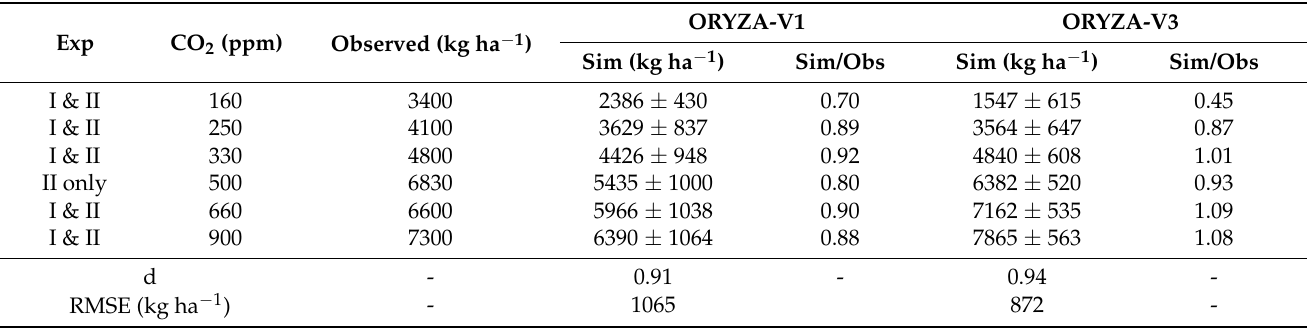
Table 3. Comparison of observed (Obs) and simulated (Sim) rice grain yield for ORYZA-V1 and ORYZA-V3 model versions in response to varying CO 2 concentrations. Data were averaged from two different experiments, Exp I and II, that varied in planting date (22 January or 23 June) from [52]. The ratio of simulated to observed yield (Sim/Obs) was indicated along with Wilmott’s index of agreement (d) and